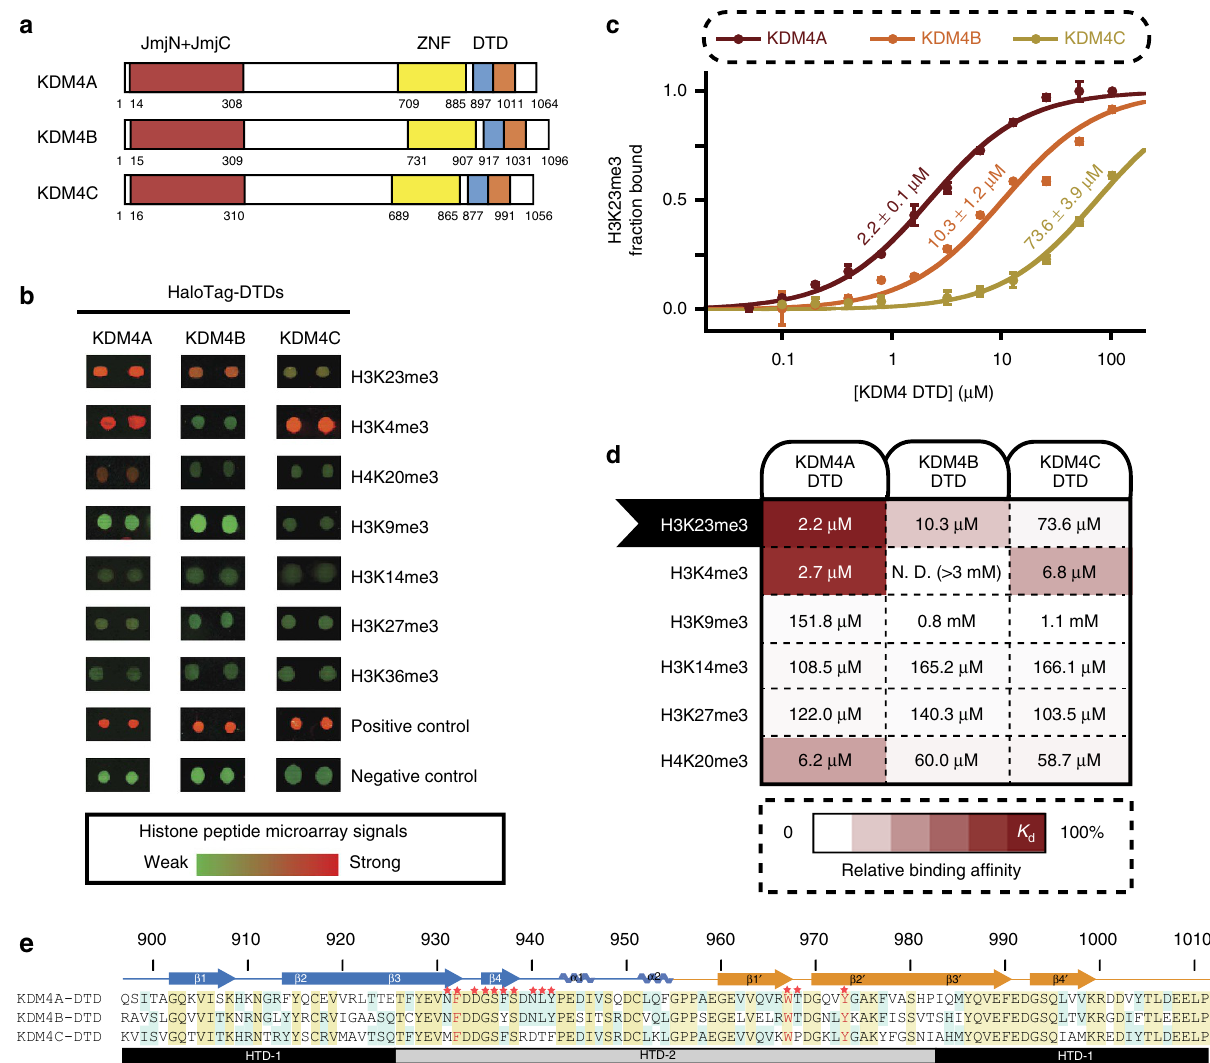
Figure 1 | Distinct binding specificities of human KDM4A–C DTDs. ( a ) Domain organization of human KDM4 family members (DTD, double